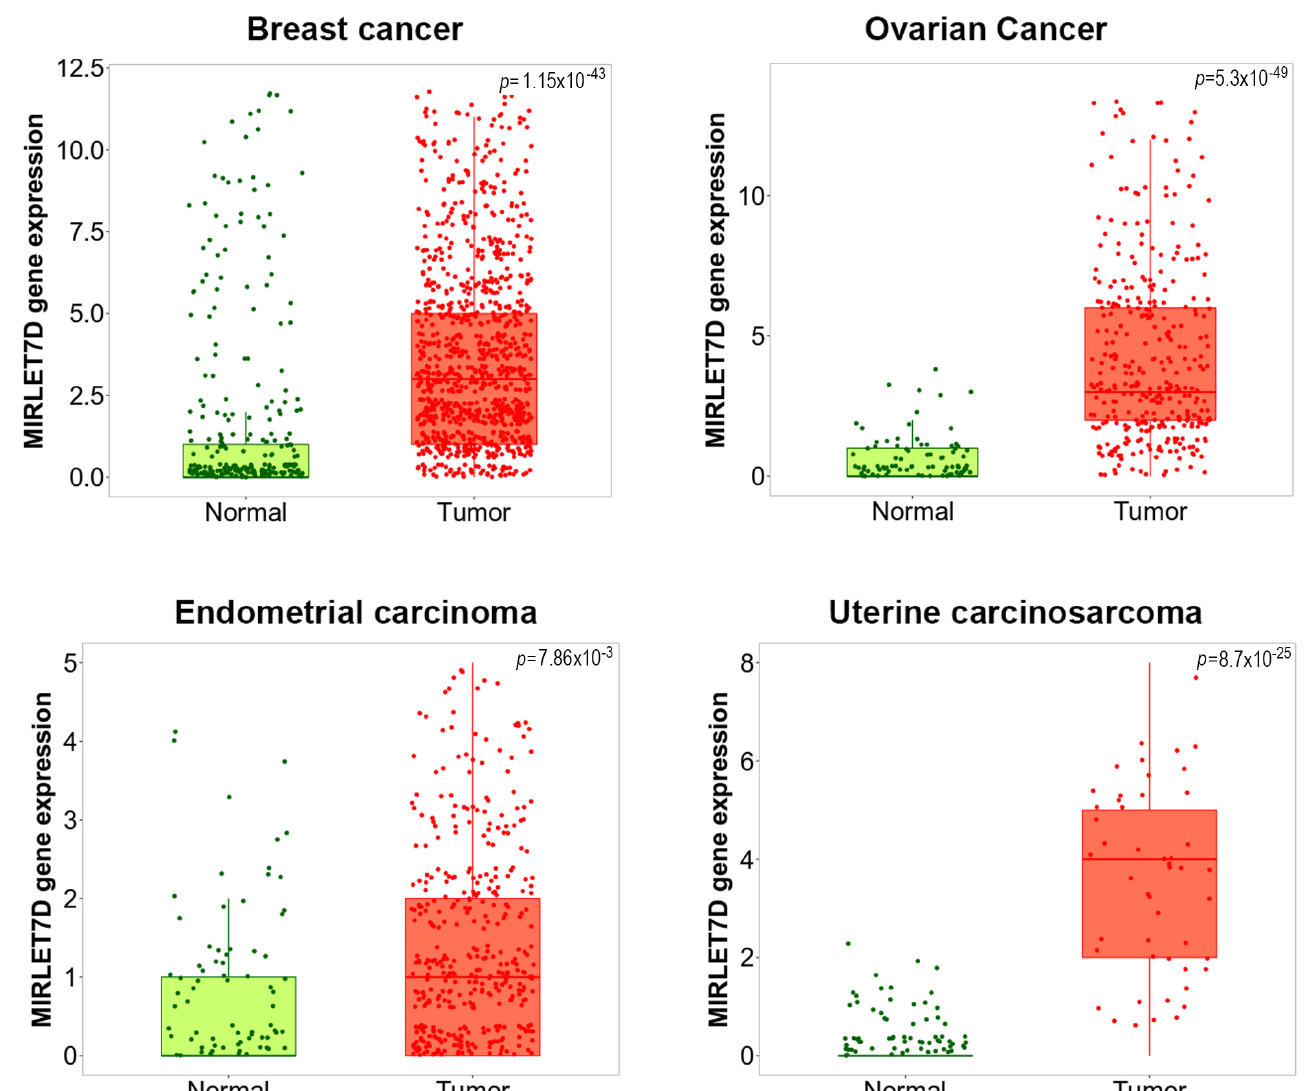
Figure 2. Let-7d is upregulated in a variety of gynecological malignancies. RNASeq-based let-7d expression data were retrieved from the TNMPlot database [93]. In the box plots, bars show the proportions of tumor samples displaying higher expression of the selected gene compared to normal samples at each of the quantile cutoff values (minimum, 1st quartile, median, 3rd quartile, maximum). p -values below 0.05 indicate significant differences as assessed by Mann–Whitney test. Significant let-7d upregulation between normal and tumor tissues was observed for invasive breast carcinoma (“Breast cancer”, 403 normal/1097 tumor samples), ovarian serous cystadenocarcinoma (“Ovarian cancer”, 133 normal/374 tumor samples), uterine corpus endometrial carcinoma (“Endometrial cancer” 146 normal/547 tumor samples), and uterine carcinosarcoma (111 normal/56 tumor samples). See reference [93] for a description of retrieved gene expression data and patient collectives.